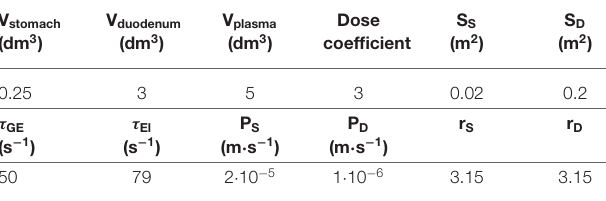
TABLE 3 | The parameters employed in Equations